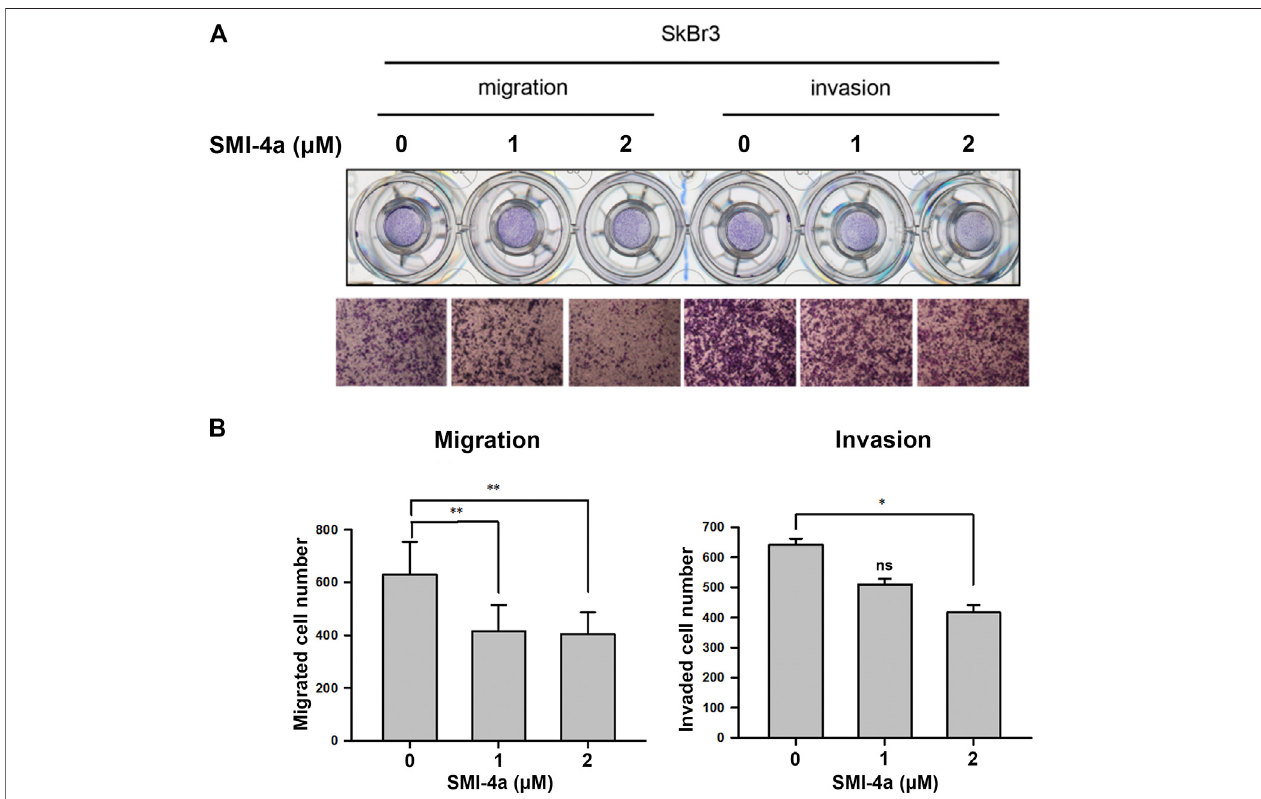
FIGURE4| Pim1inhibitor attenuated cell migrationand invasionabilitiesin HER2-positive SkBr3cells. (A,B) SkBr3cells weretreatedwithSMI-4a at0, 1,2 μ M for 2 daysandsubjectedto invitro transwellassay.Cellmigrationandinvasionwereobservedundermicroscopeandbycrystalvioletstaining (A) .Thenumbersofmigrated andinvadedcellswerecalculatedandquanti fi ed (B) .Resultswereexpressed asmean ± S.E.M.ofthreeindependentexperiments.*: p < 0.05;**: p < 0.01ascompared with control group.